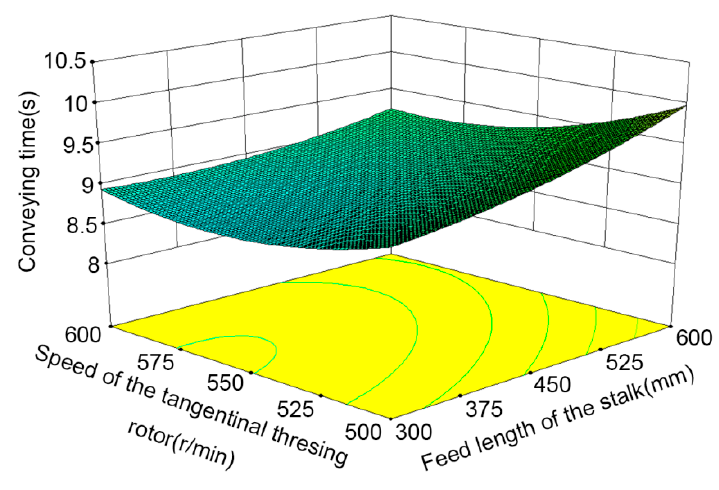
Figure 11. Effect of the interaction of factors on the conveying time.